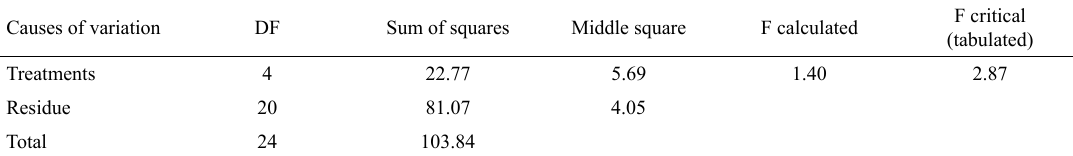
Table 2. Variance analysis for ballistic tests with MAS having different second layers.